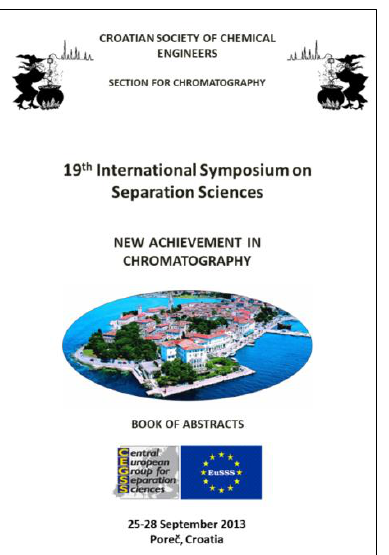
Figure 4. Book of Abstracts from the 19th ISSS symposium, Poreč, Croatia, 2013.